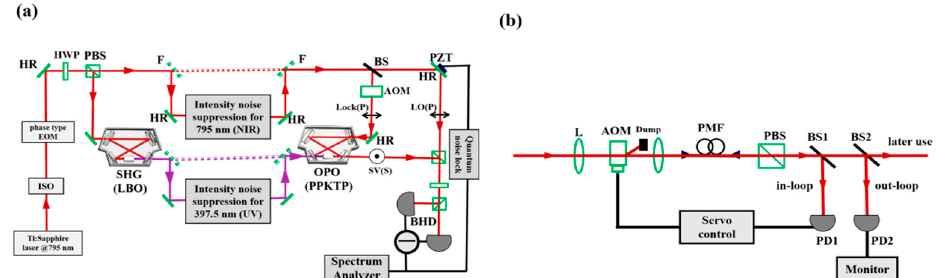
Figure 1. ( a ) Schematic diagram of experimental setup for preparing the squeezed vacuum state of 795-nm light at audio frequency. The dotted line path means without feedback and the solid line represents noise suppression via feedback. ( b ) Diagram of experimental setup of the AOM feedback system. Both 795-nm NIR and 397.5-nm UV laser’s AOM feedback systems are similar. ISO: Optical isolator; EOM: Electro-optical modulator; NIR: Near infrared; UV: Ultraviolet; HWP: Half-wave plate; PBS: Polarization beam splitter cube; BS: Beam splitter plate; L: Lens; AOM: Acousto-optical modulator; D: Dump; PMF: Polarization-maintaining fiber; PD: Photo-detector; HR: High-reflectivity mirror; SHG: Second-harmonic generation cavity; OPO: Optical parametric oscillator cavity; SV: Squeezed vacuum state of light; LO: Local oscillator beam; S: S polarization; P: P polarization; BHD: Balanced homodyne